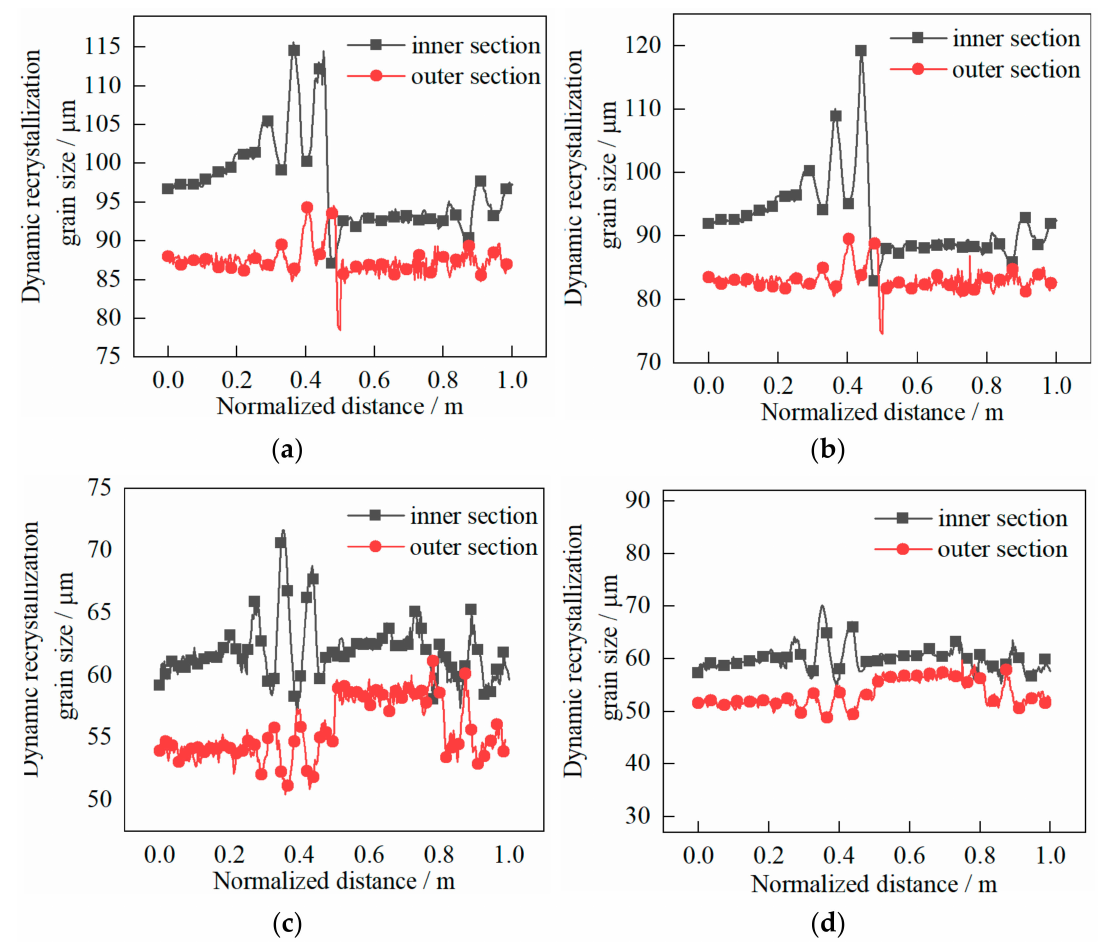
Figure 17. Evolution characteristics of recrystallization grain size in two passes of rolling: ( a ) first pass rolling, without shear effect; ( b ) first pass rolling, with shear effect; ( c ) second pass rolling, without shear effect; ( d ) second pass rolling, with shear